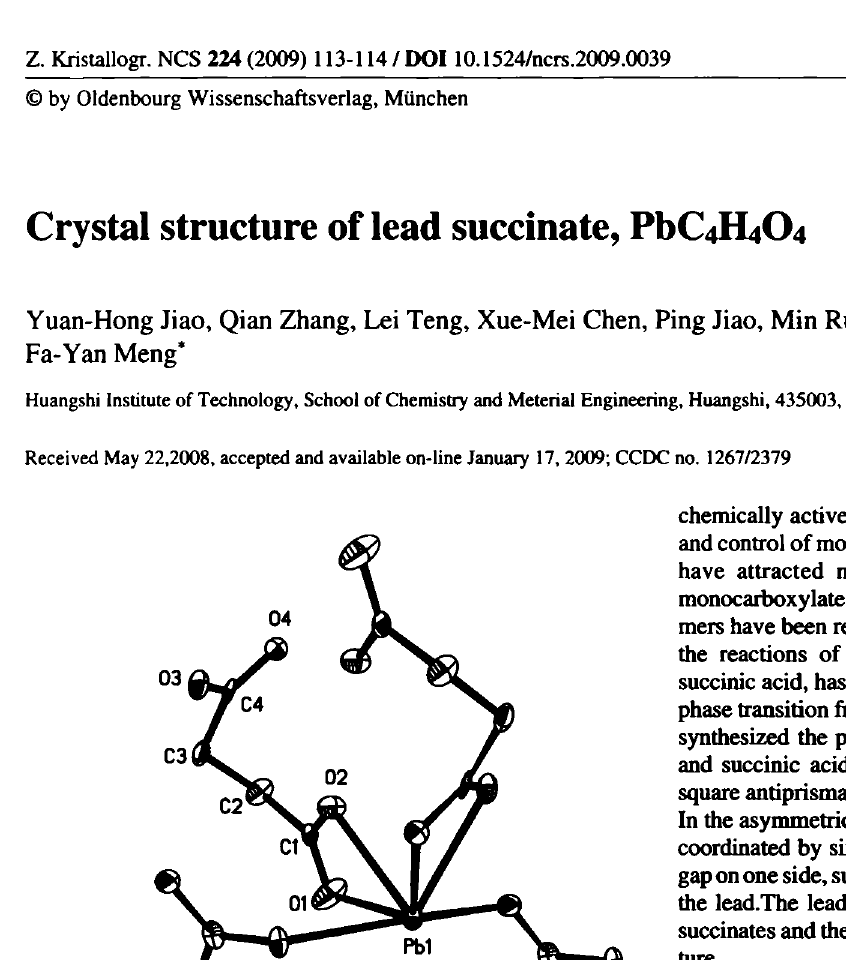
Table 1. Data collection and handling.